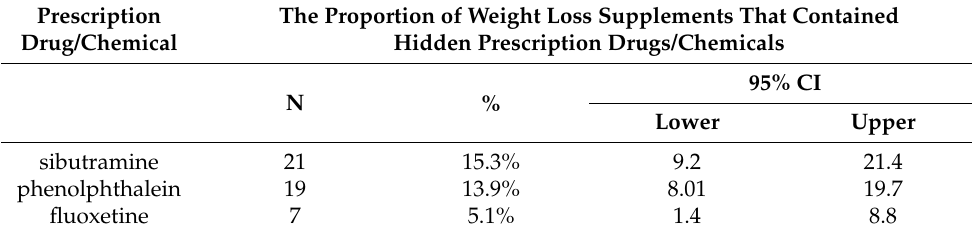
Table 3. Estimation of hidden prescription drugs and chemicals in weight loss supplements.